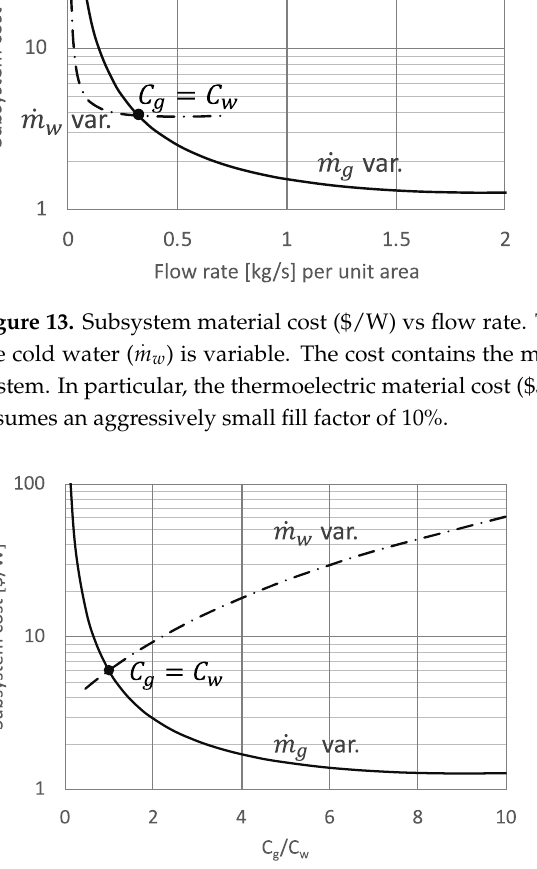
Figure 14. Subsystem material cost ($/W) vs heat capacity ratio C g / C w . Based on the US national average end-user electricity cost of $0.1165 per watt for all sectors in August 2021 [29], the return-on-investment (ROI) time of 3.97 years is calculated at the design point of C g = C w . The minimum ROI time was found to be 1.24 years at . . m g = 2.0 kg/s and m w = 0.05 kg/s, where both are per unit energy harvesting